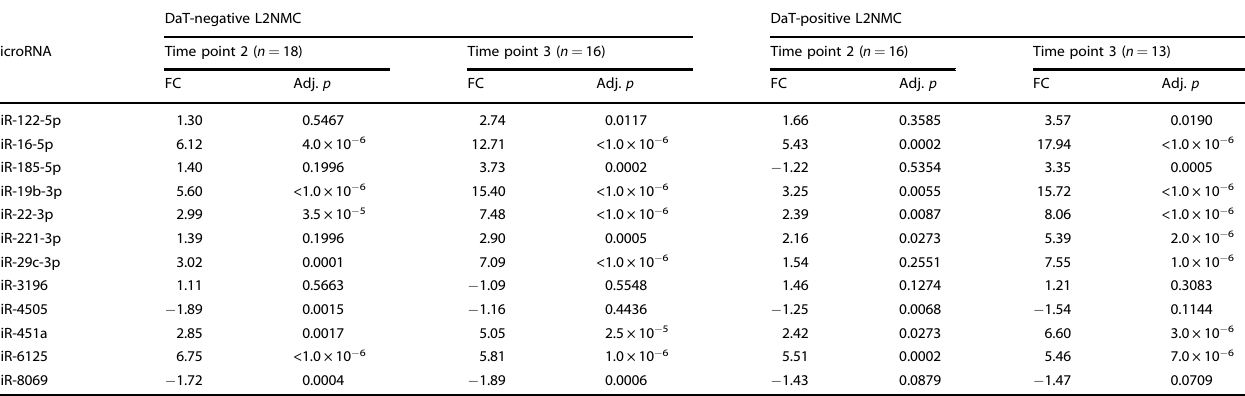
Table 3. Longitudinal follow-up of serum miRNA levels during 8 years in DaT-negative and DaT-positive L2NMC with respect to their baselines.